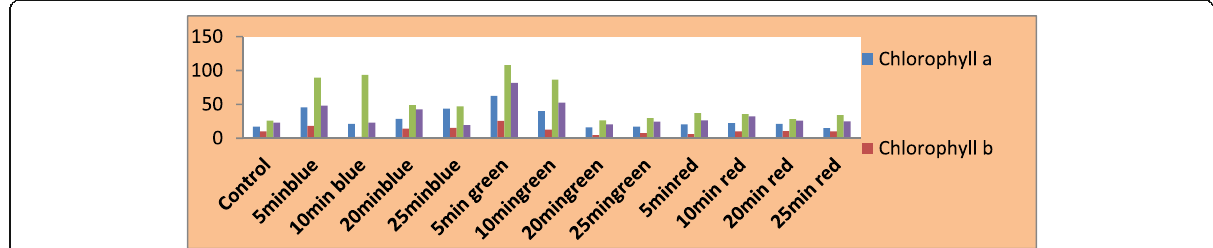
Fig. 2 Effect of laser irradiation on photosynthetic pigments content of in vitro Eustoma grandiflorum